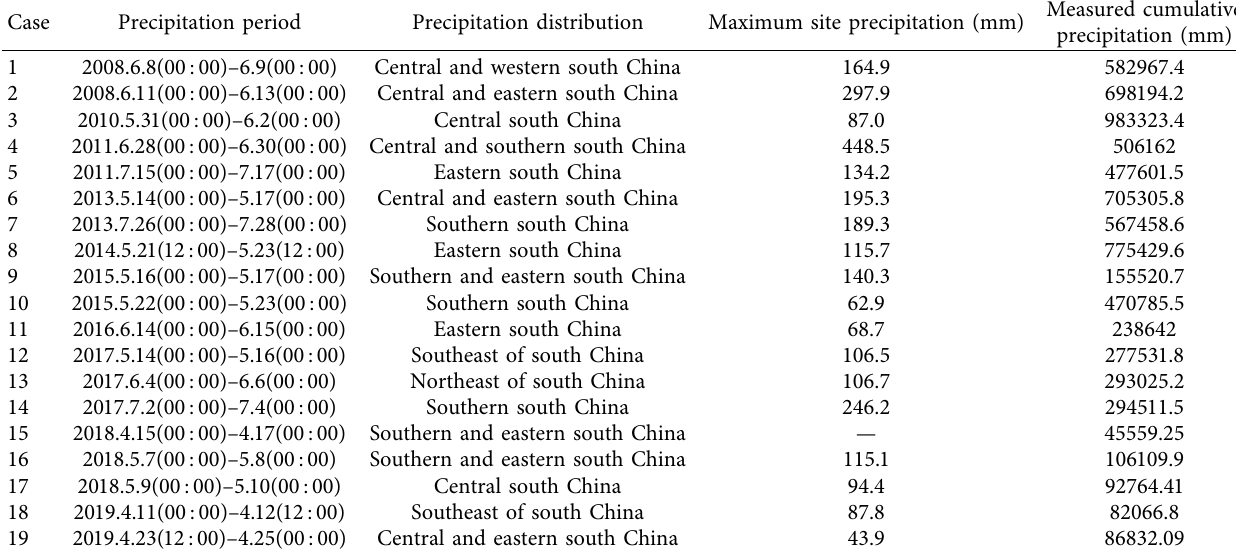
Table 1: Details of the cases used, including the time period, distribution, and cumulative amount of precipitation.